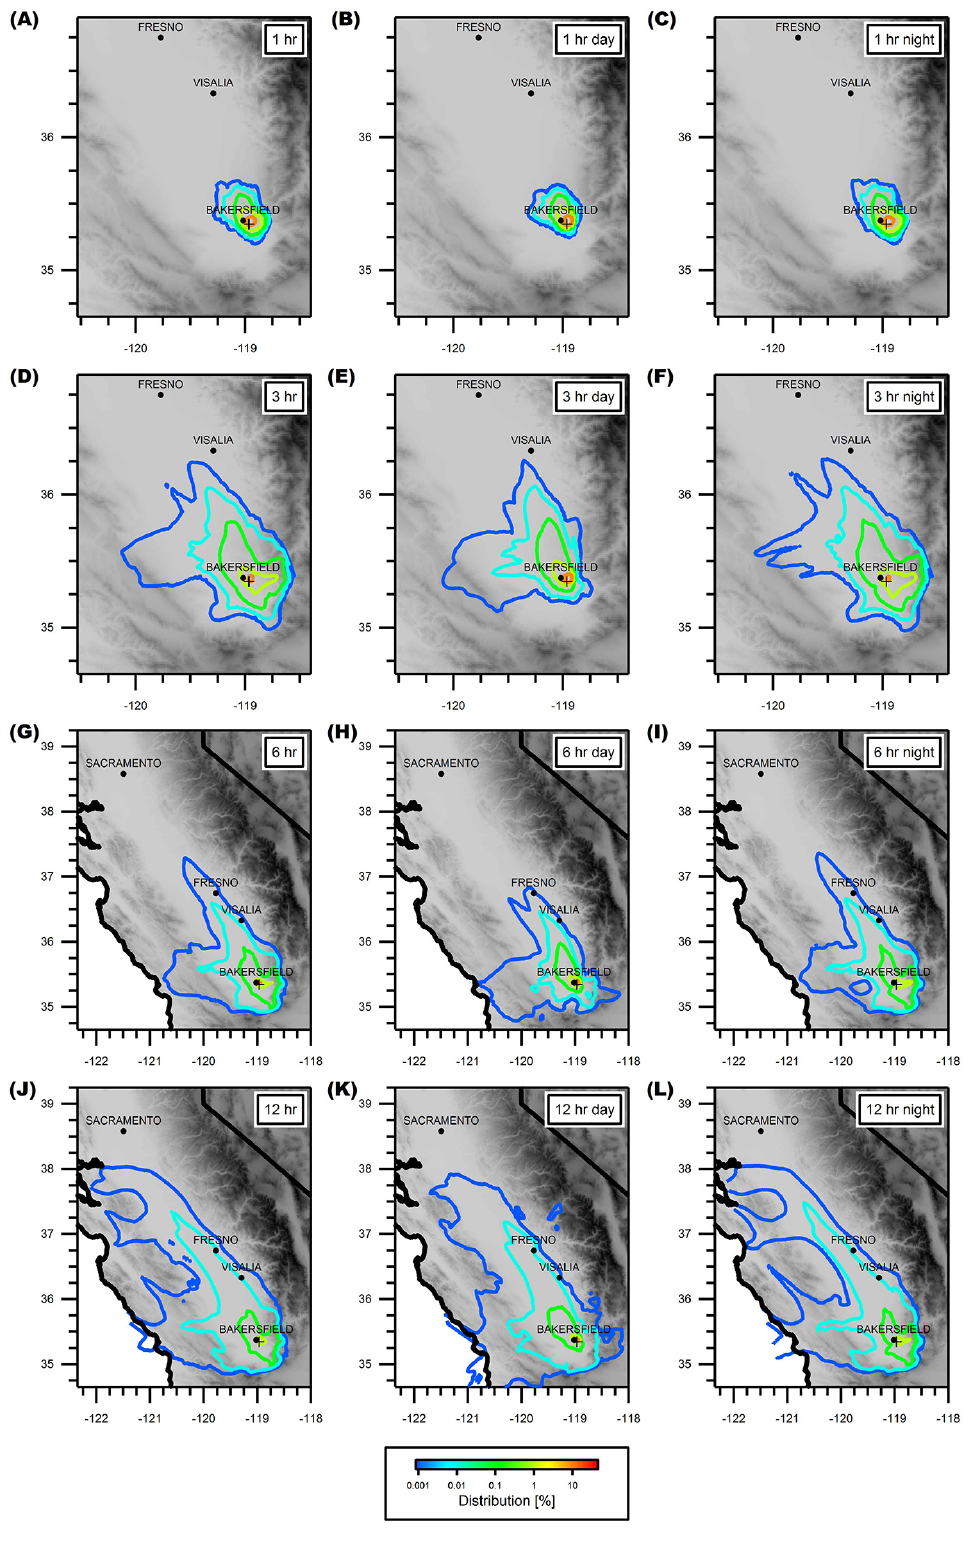
Figure 1. 1, 3, 6 and 12 h statistical footprints for the Bakersfield ground site (marked by + ) averaged across the entire CalNex campaign ( y and x axes represent latitude and longitude, respectively). Daytime (B, E, H, K) and nighttime (C, F, I, L) averages are filtered for 08:00–20:00 PST and 21:00–06:00 PST, respectively, and are shown with overall averages (A, D, G, J)